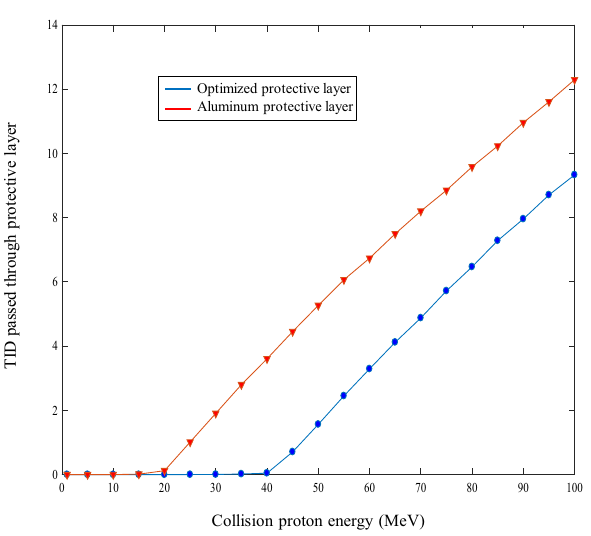
Figure 6. Total ionizing dose versus particle energy for optimized three-layer and Aluminum shield (the blue curve is related to a three-layer